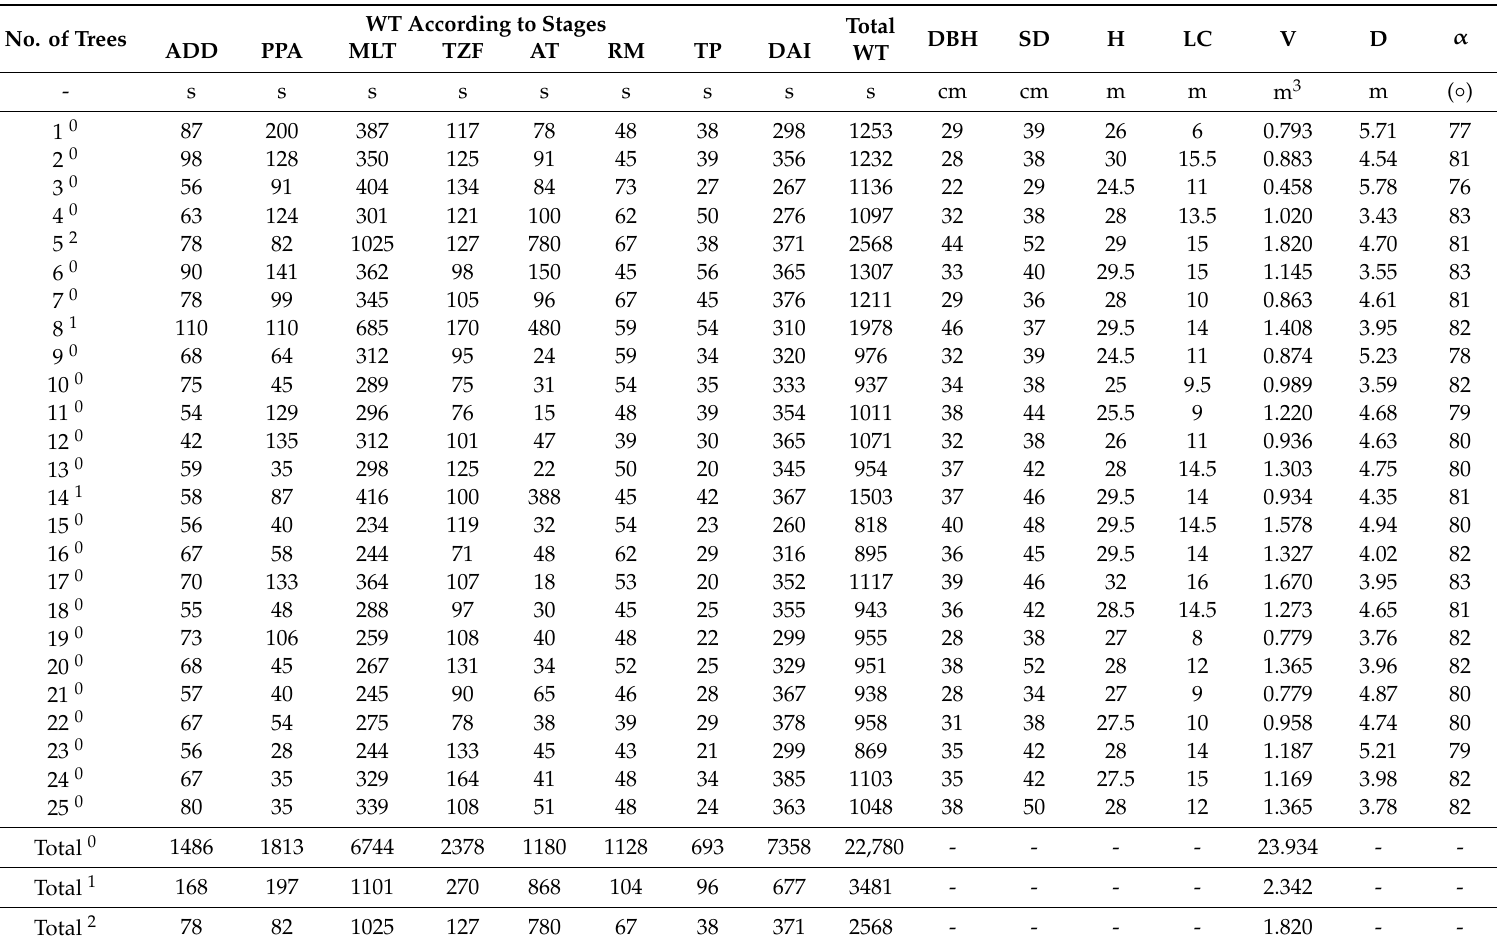
Table 4. The working time corresponding to the stages in the felling of hung up trees and the operational variables measured. No. of